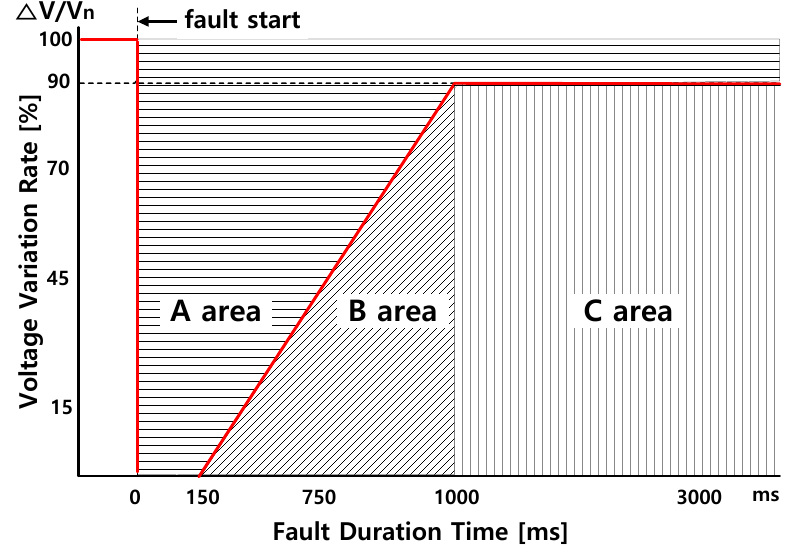
Figure 5. The LVRT